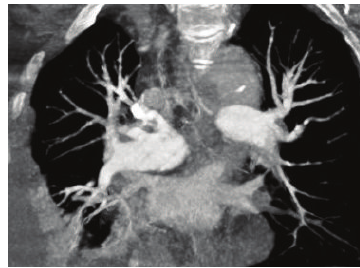
Figure 1: Computed tomogram shows right pleural effusion, web- like filling defects, and endoluminal thromboemboli extending into the right and left pulmonary artery.